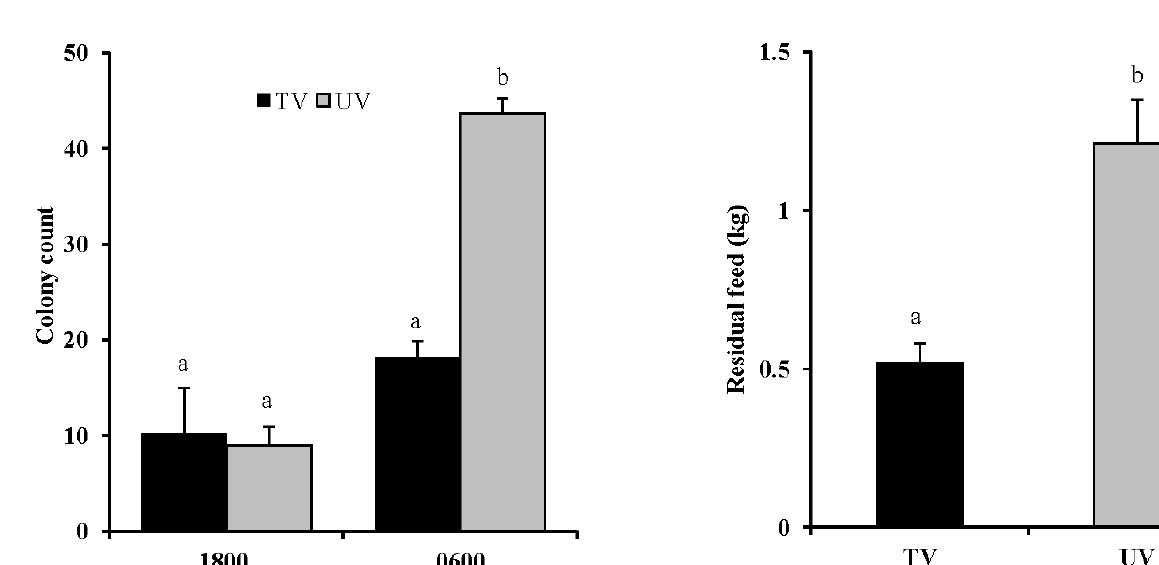
Table 3. Lactation perfomance in the unventilated (UV) condition and tunnel-ventilated (TV) system (n = 30) 1),2) Items